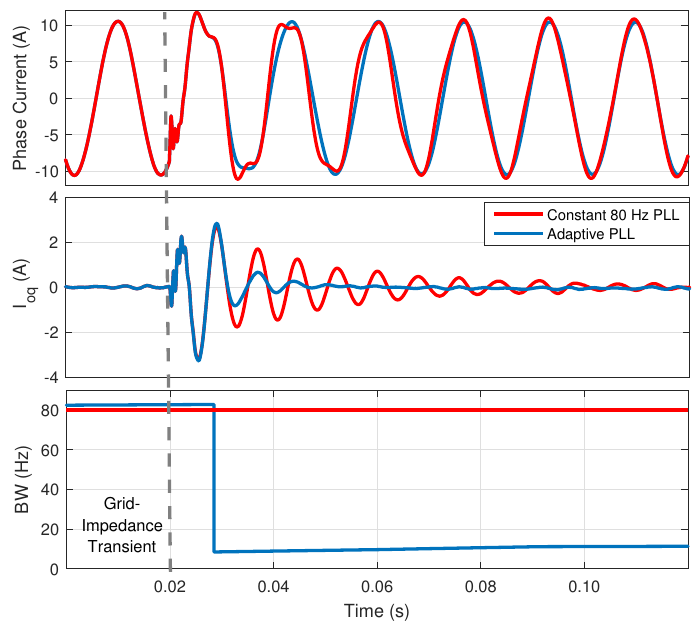
Figure 10. Performance comparison of adaptive and 80 Hz PLL in weakening grid